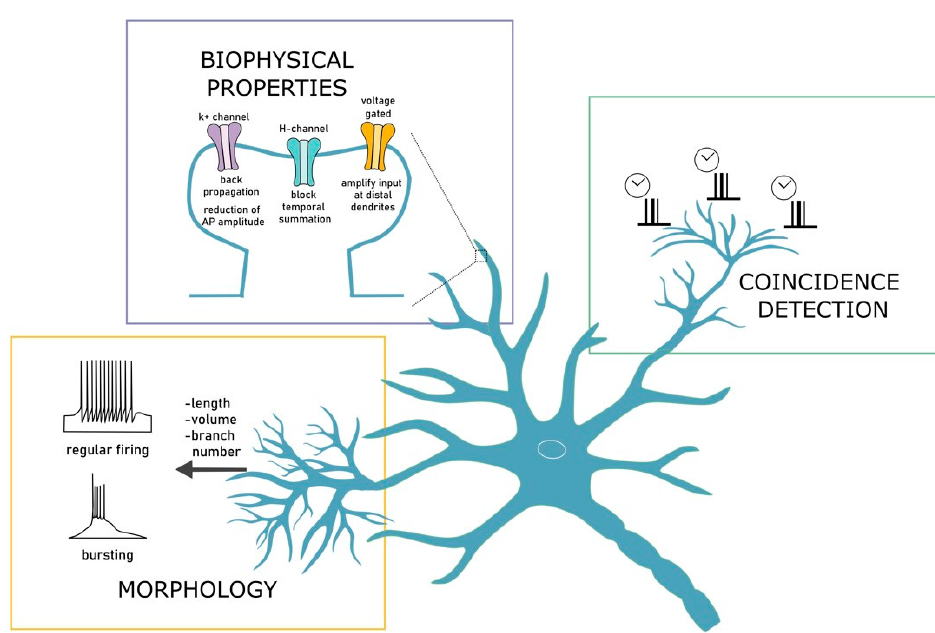
Figure 1. Dendritic modeling. Dendrites are the main participants in neuronal communication. Their morphological, biophysical and integration properties influence neuronal activity. Morphology, in terms of dendritic length, volume and branch number, contributes to discriminate from regular to bursting firing, and influences functional properties as bursting rates, threshold and tendency to induce bursts. Biophysical properties reveal how ion channels features influence, for example, synaptic integration, membrane potential changes, signal propagation and synaptic plasticity. Bio- physical models helped to unravel the contribution of channels in the modulation of AP generation and temporal properties. Finally, conductance, morphology and timing interact to the emergence of coincidence detection, making dendrites serve as timers of somatic